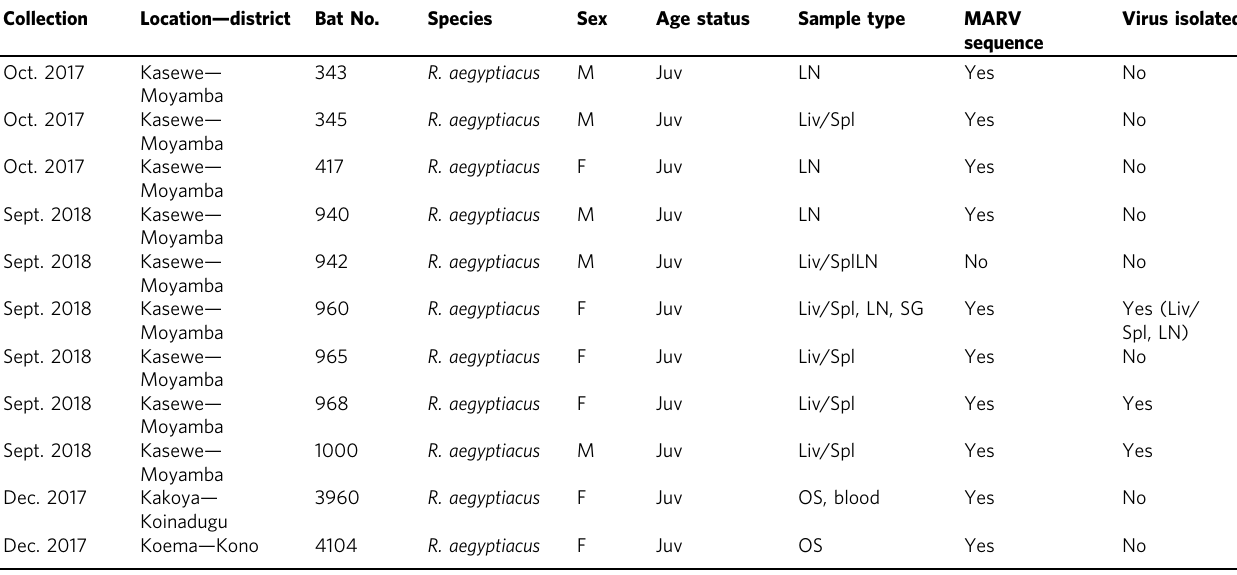
Table 1 Summary of MARV infected tissues sampled from Rousettus aegyptiacus in Sierra Leone. Collection Location — district Bat